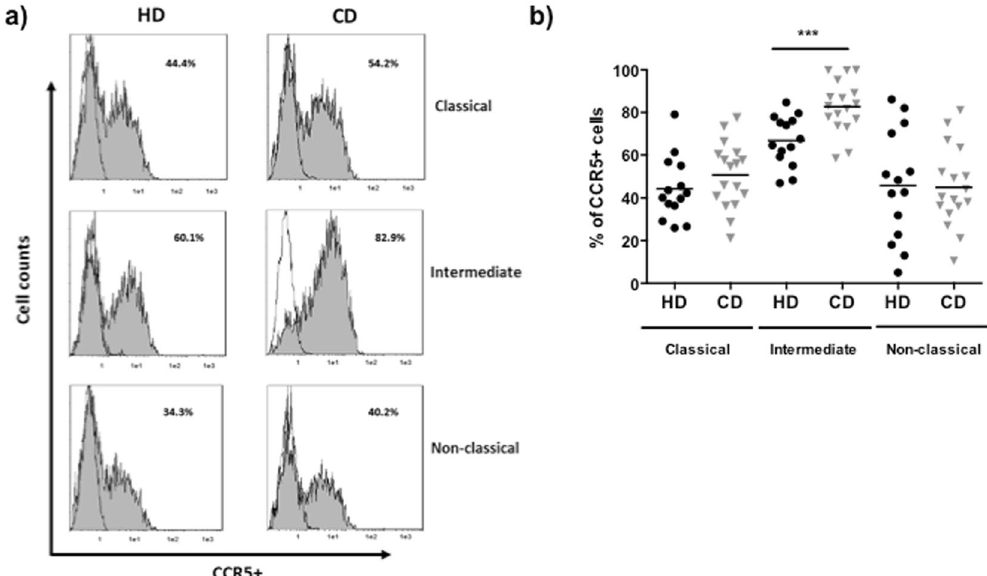
Figure 1. CCR5 expression on monocytes from HD and CD patients in remission. ( a ) A representative experiment of CCR5 expression on gated CD14 + CD16 − (classical), CD14 + CD16 + (intermediate) and CD14low CD16 ++ (non-classical) monocytes from a HD and a CD patient by flow cytometry (unshaded histogram: isotype control, gray shaded histogram: anti-CCR5 antibodies). ( b ) The percentage of CCR5 + classical, intermediate and non-classical monocytes by flow cytometry at 24 h of WB culture from HD (n = 14) and inactive CD patients (n = 17). Multiple comparisons were calculated by ANOVA for HD (p = 0.004) and for CD patients (p < 0.0001). Mann-Whitney U test was used for comparisons between each subset of monocytes from HD and inactive CD patients ( *** p <